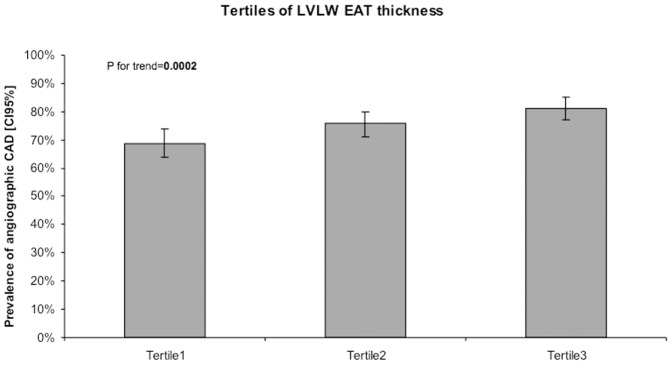
Association of angiographic coronary artery disease and left ventricle lateral wall (LVLW) epicardial adipose tissue (EAT) thickness tertile classification.CAD  =  coronary artery disease; LVLW  =  left ventricle lateral wall; EAT  =  epicardial adipose tissue. Prevalence of angiographic coronary artery disease and 95% confidence intervals [95% CIs] in LVLW EAT tertiles.